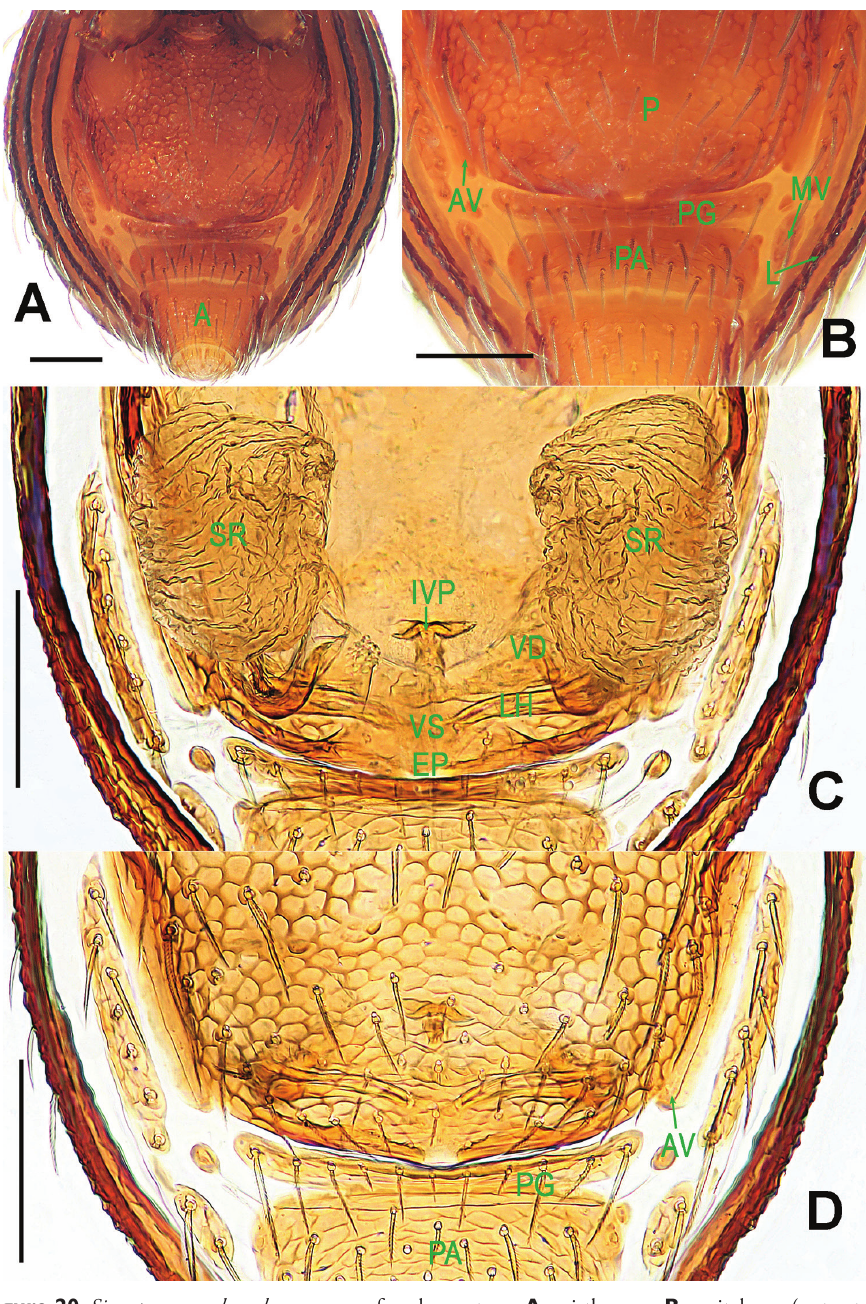
Figure 20. Singaporemma lenachanae sp. n., female paratype. A opisthosoma B genital area (untreated) C cleared vulva (lactic acid-treated) D ditto . A–B, D ventral C dorsal. Abbreviations: A = anal plate; AV = anterior ventrolateral plate; EP = epigynal pit; IVP = inner vulval plate; L = lateral plate; LH = lateral horn; MV = median ventrolateral plate; PA = preanal plate; PG = postgenital plate; SR = seminal receptaculum; VD = vulval duct; VS = vulval stem. Scale bars: 0.10